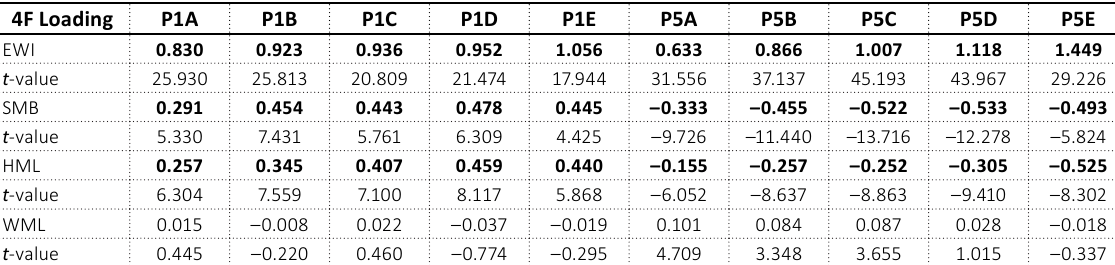
Table 11. Regres sion coefficient analysis of three-factor (Fama-French) alpha of portfolios independently sorted on size and volatility with their corresponding t -value